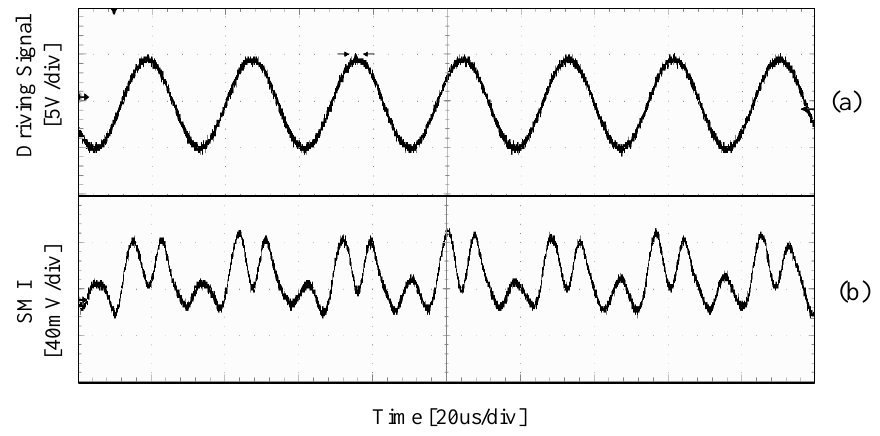
Figure 10. Driving signal on the ultrasonic transducer and its corresponding SMI signal. ( a ) Driving signal for the ultrasonic transducer, ( b ) corresponding SMI signal.